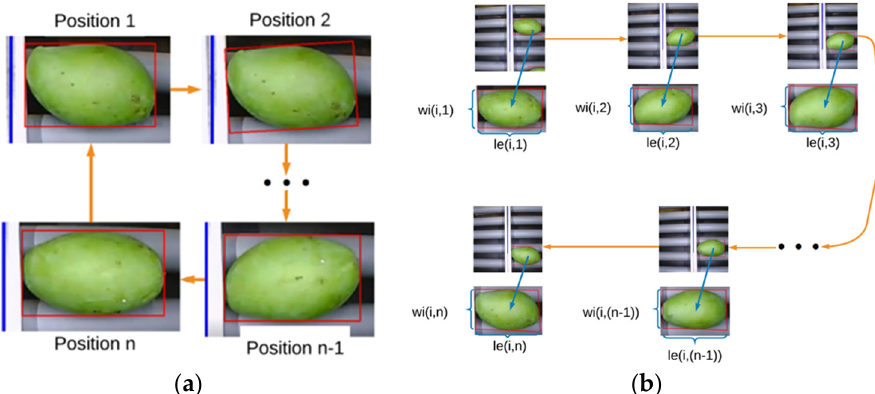
Figure 9. Extracting the length and width based on directions of mango. ( a ) The mango is detected by a rectangle covering them based on image processing algorithms, ( b ) the process of detecting mangoes and extracting length and width.